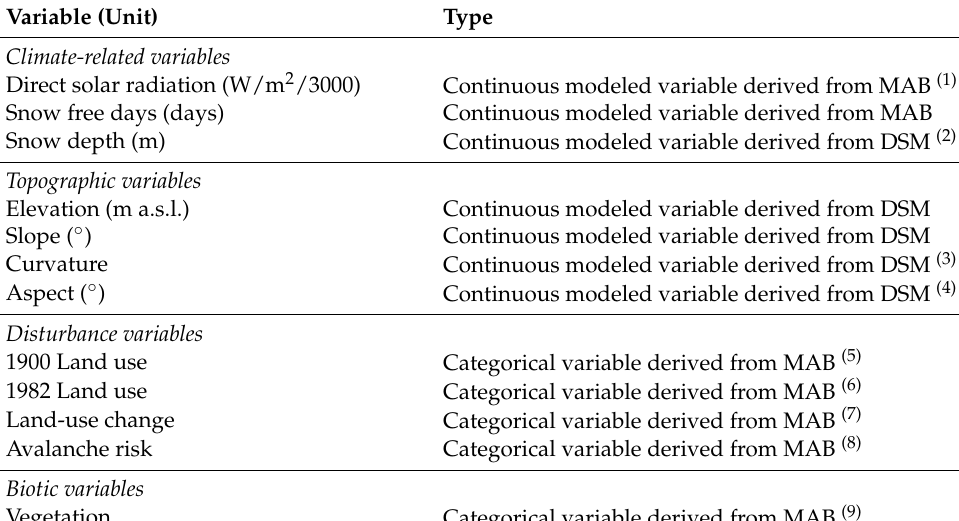
Table 1. Explanatory variables used to analyze treeline advance in a decision tree